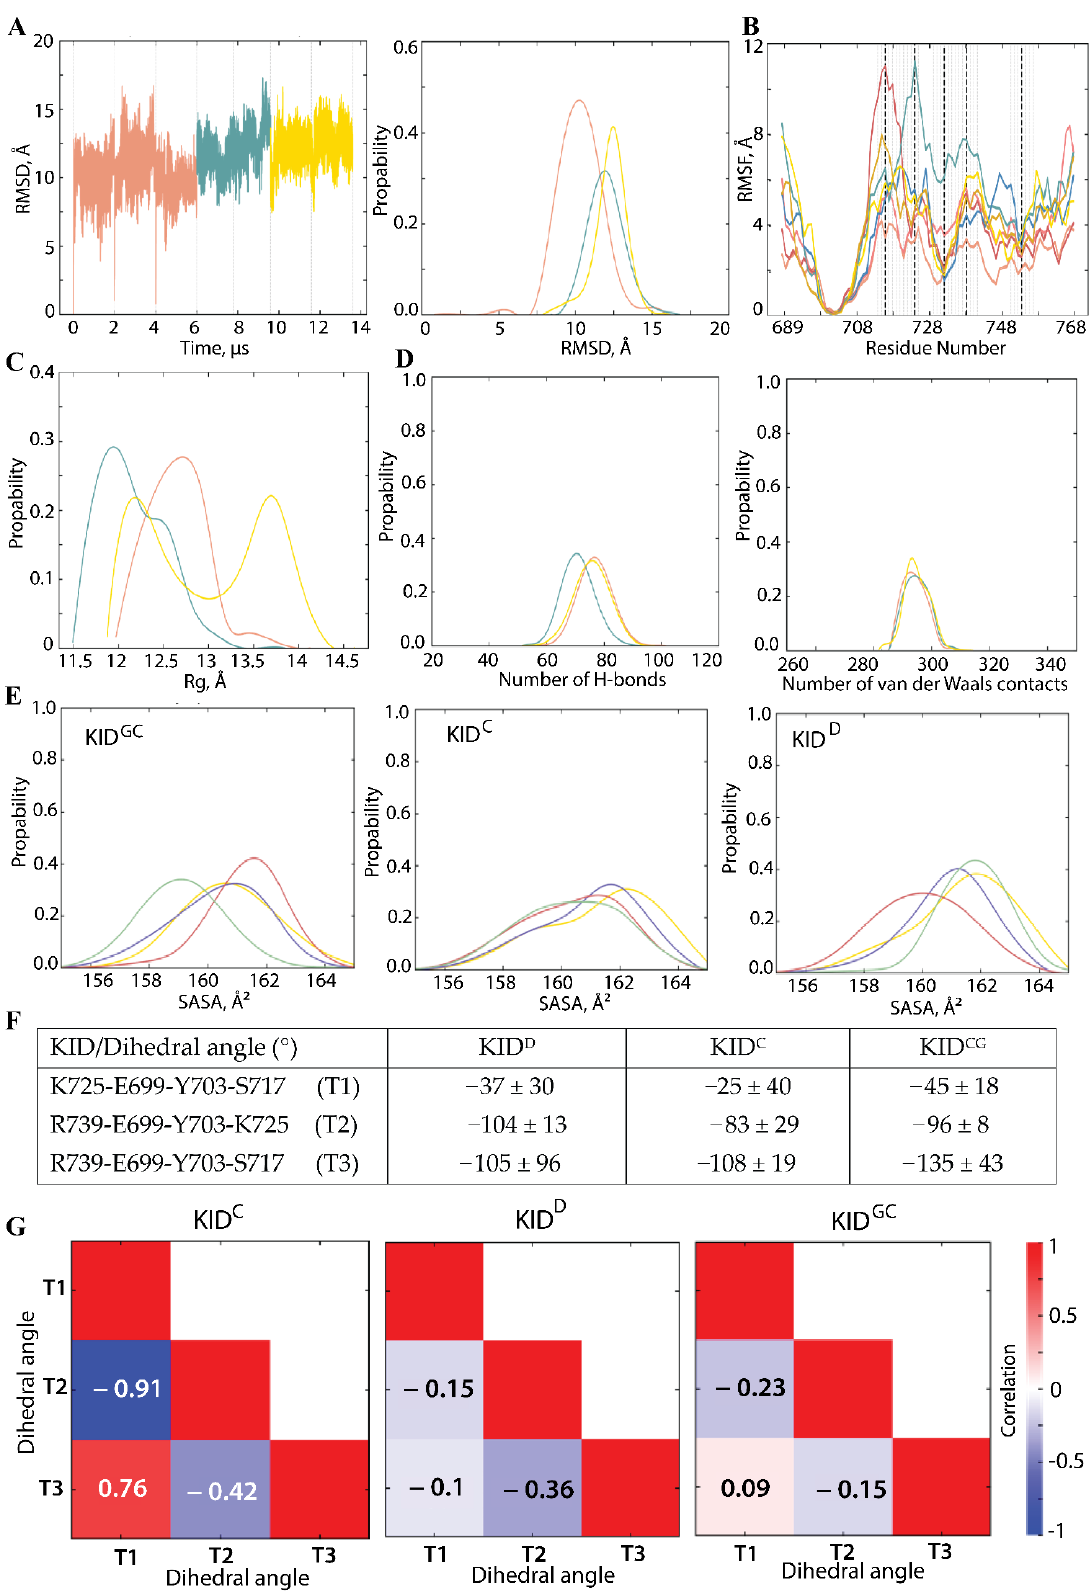
Figure 4. Comparative characterisation of KID using the conventional molecular dynamics (cMD) simulations of different KID entities. ( A ) RMSD was computed on the C α -atoms (left) as well as ts probability (right). ( B ) RMSF was calculated on the C α atoms of KID GC (yellow, sand), KID D (red,